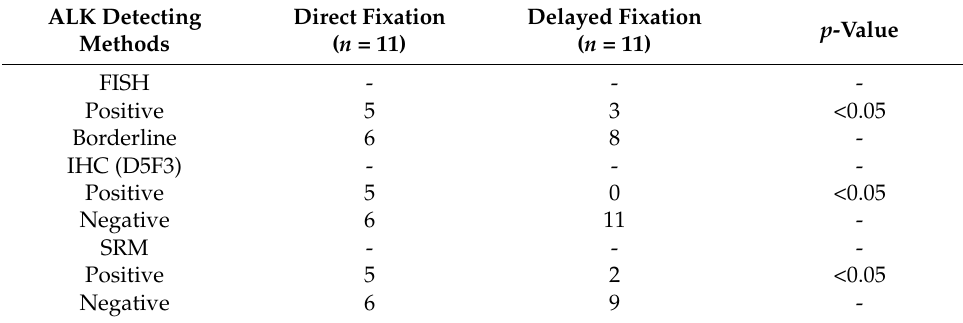
Figure 1. Illustration of additional immunohistochemistry with 5A4 and D5F3 antibodies, and SRM of cases previously discordant for anaplastic lymphoma kinase ( ALK ) FISH and ALK immunohistochemistry. Case number 1 is borderline- positive for ALK FISH, positive (1+) for 5A4, positive for D5F3, and positive for SRM. Case number 6 is positive for ALK FISH, positive (3+) for 5A4, positive for D5F3, and positive for SRM. Case number 14 is positive for ALK FISH, negative (0) for 5A4, negative (weak staining) for D5F3, and positive for SRM, and case number 21 is positive for ALK FISH, negative (0) for 5A4, positive (focal strong staining) for D5F3, and positive for SRM. Scale bars: 50 µ m. Case numbers are summarized in Table S1. FISH, fluorescent in situ hybridization. SRM, selected reaction monitoring. BP, borderline-positive. P, positive. N, negative. Table 3. The association between tissue fixation and ALK test